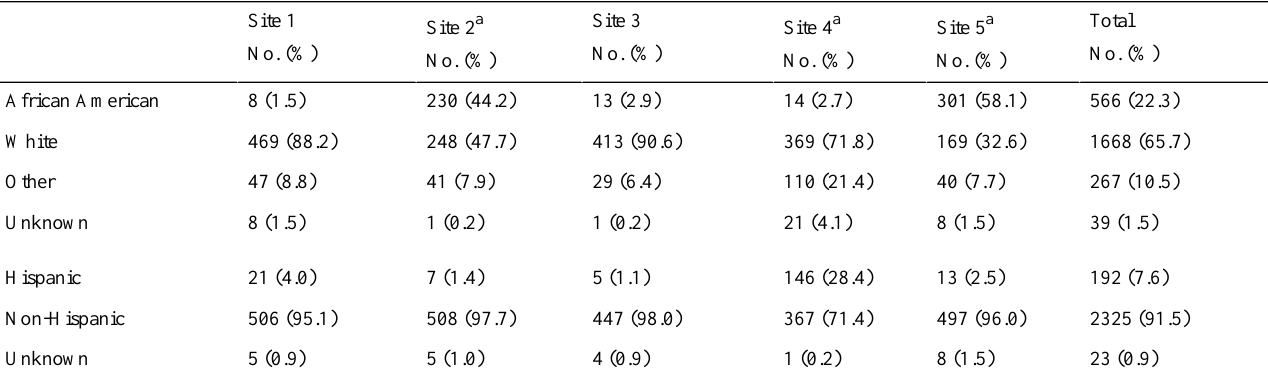
Table 5. Race and ethnicity of MENU